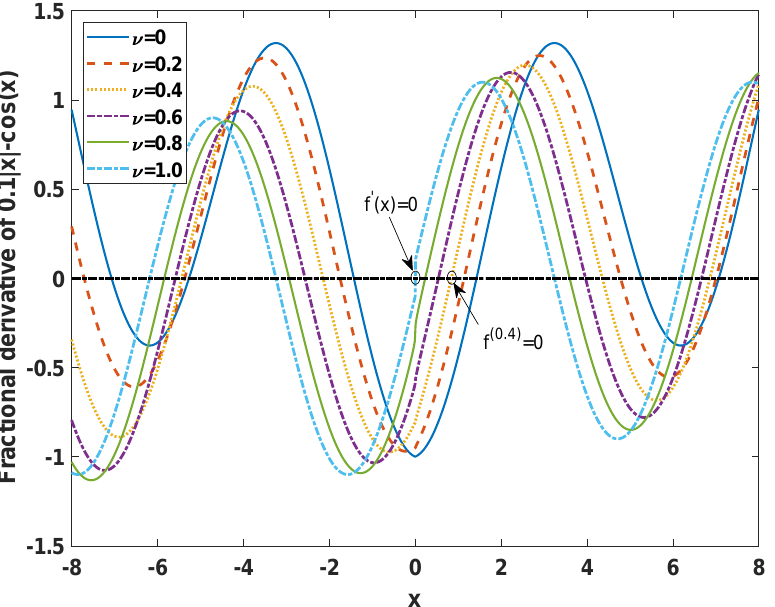
Figure 1. Demonstration of fractional order local optimal points of fractional order derivatives of 0.1 | x | − cos ( x ) with different orders ν . The horizontal axis denotes the variable x ’s range [ − 8,8 ] . The vertical axis denotes the fractional order derivatives with different orders ν ∈ [ 0,0.2,0.4, 0.6, 0.8.1.0 ] . The two circles denote two local extrema of different order derivatives ( ν = 1 ( left ) , 0.4 ( right )